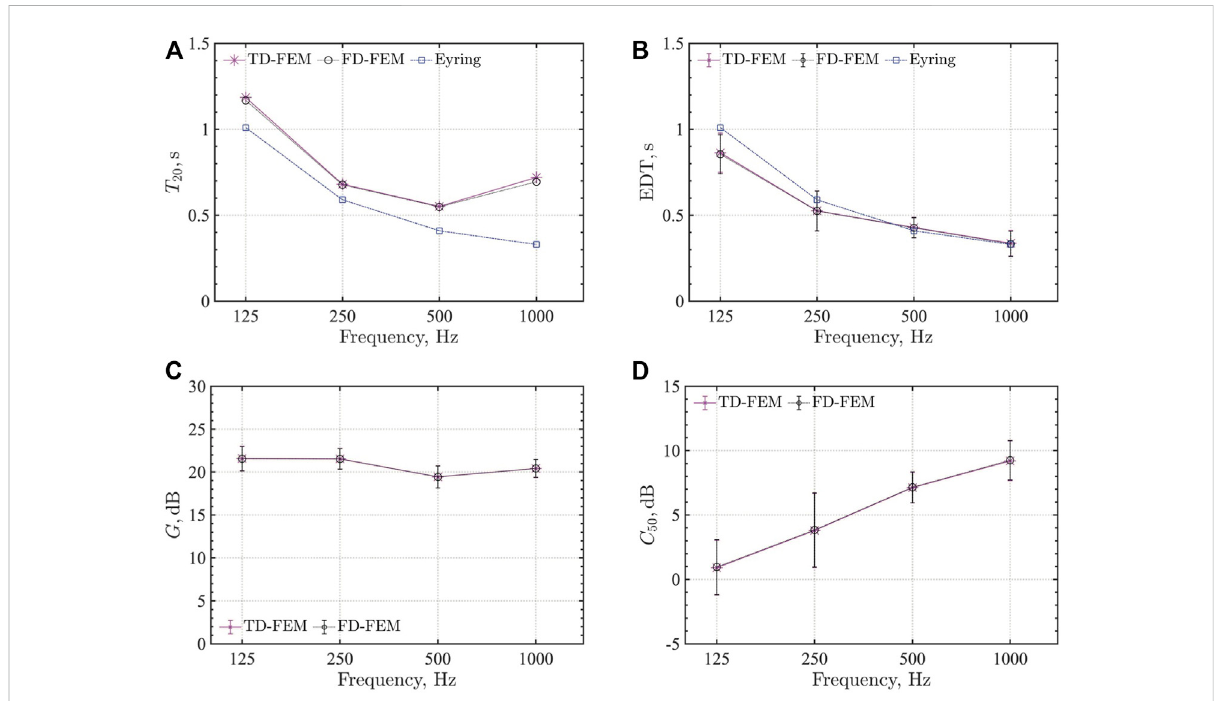
TABLE 3 Accuracy measures on four room-acoustic parameters at each frequency: D T Frequency,